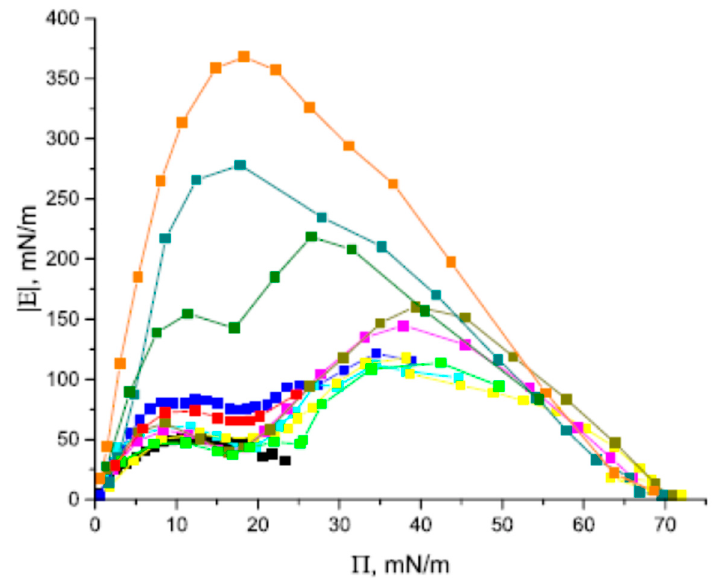
Figure 15. Module of dynamic surface elasticity of mixed C60/BSA, pure BSA ( black ), and pristine C60 ( orange ) spread layers as a function of the surface pressure at C60/BSA molar ratios of 88 ( red ), 117 ( green ), 153 ( blue , cyan ), 277 ( magenta ), 392 ( yellow , dark yellow ), 877 ( olive ), and 1660 ( dark cyan ); data taken from [7].